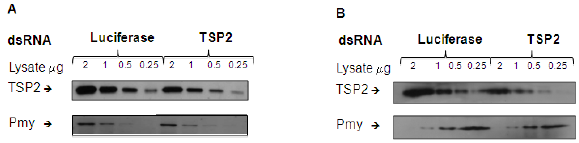
Figure 5. Protein expression levels of parasites treated with Sm-tsp-2 dsRNA. Protein extracts from adult parasites (A) and schistosomula (B) treated with Sm-tsp-2 or luciferase dsRNAs for 7 days were loaded onto a 12% SDS-PAGE gel at 2, 1, 0.5 and 0.25 m g. Proteins were transferred onto nitrocellulose and immunoblotted with anti- Sm - TSP2 or anti- Sm -Pmy monoclonal antibodies. The intensity of para- myosin expression was evaluated to determine equal protein loading.